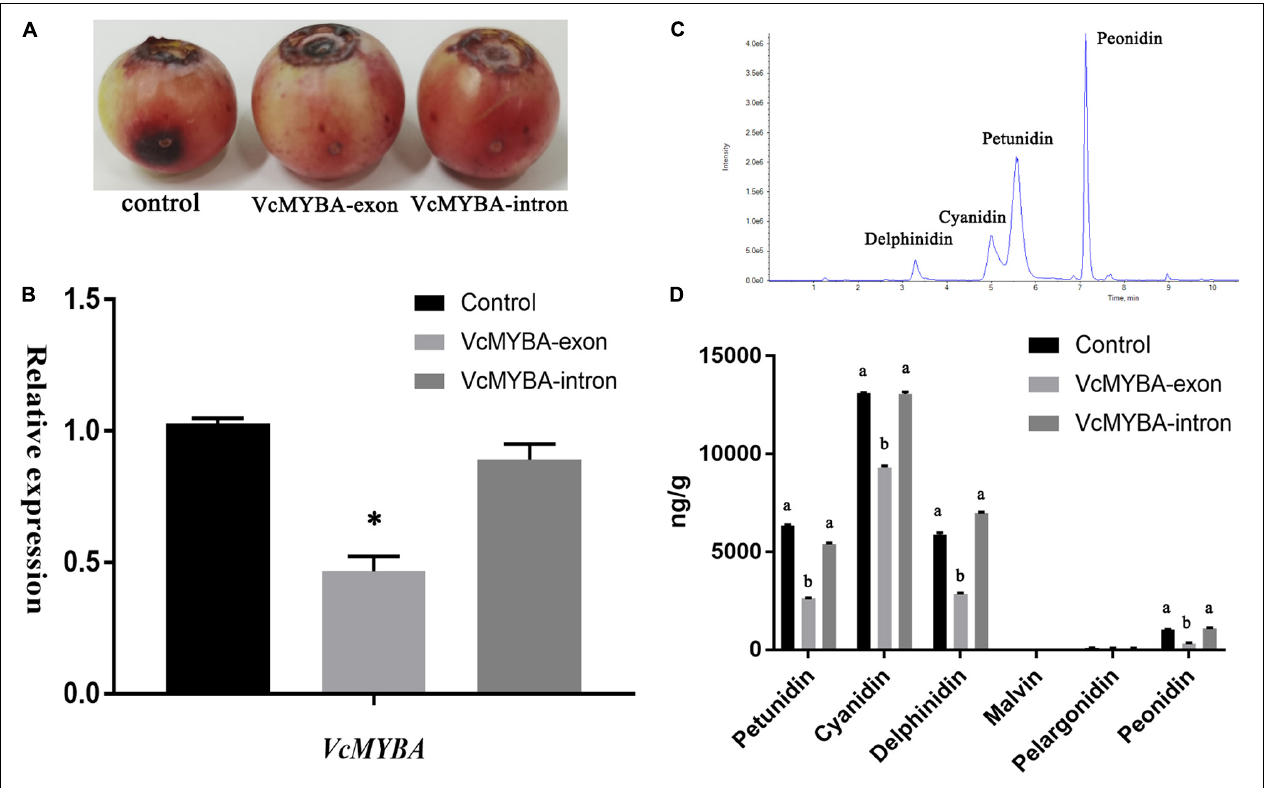
FIGURE 7 | Virus-induced gene silencing of VcMYBA in blueberry fruit. (A) Transgenic fruits 10 days after VIGS treatment. (B) qRT-PCR analysis of VcMYBA expression in treated fruits. (C) UPLC analysis of anthocyanins. (D) Contents of six anthocyanins in treated fruits. Values represent the means ± SD of three replicates. Different letters and asterisk indicates statistical significance ( P < 0.05) as determined by a one-way ANOVA test (Duncan’s multiple